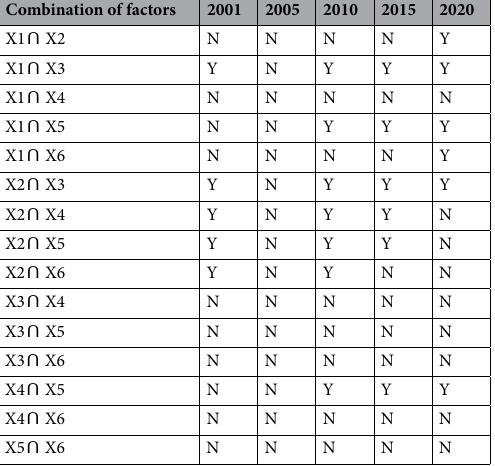
Table 9. Results of ecological detection. Y indicates that there is a significant difference between the two factors on RSEI; N indicates no significant